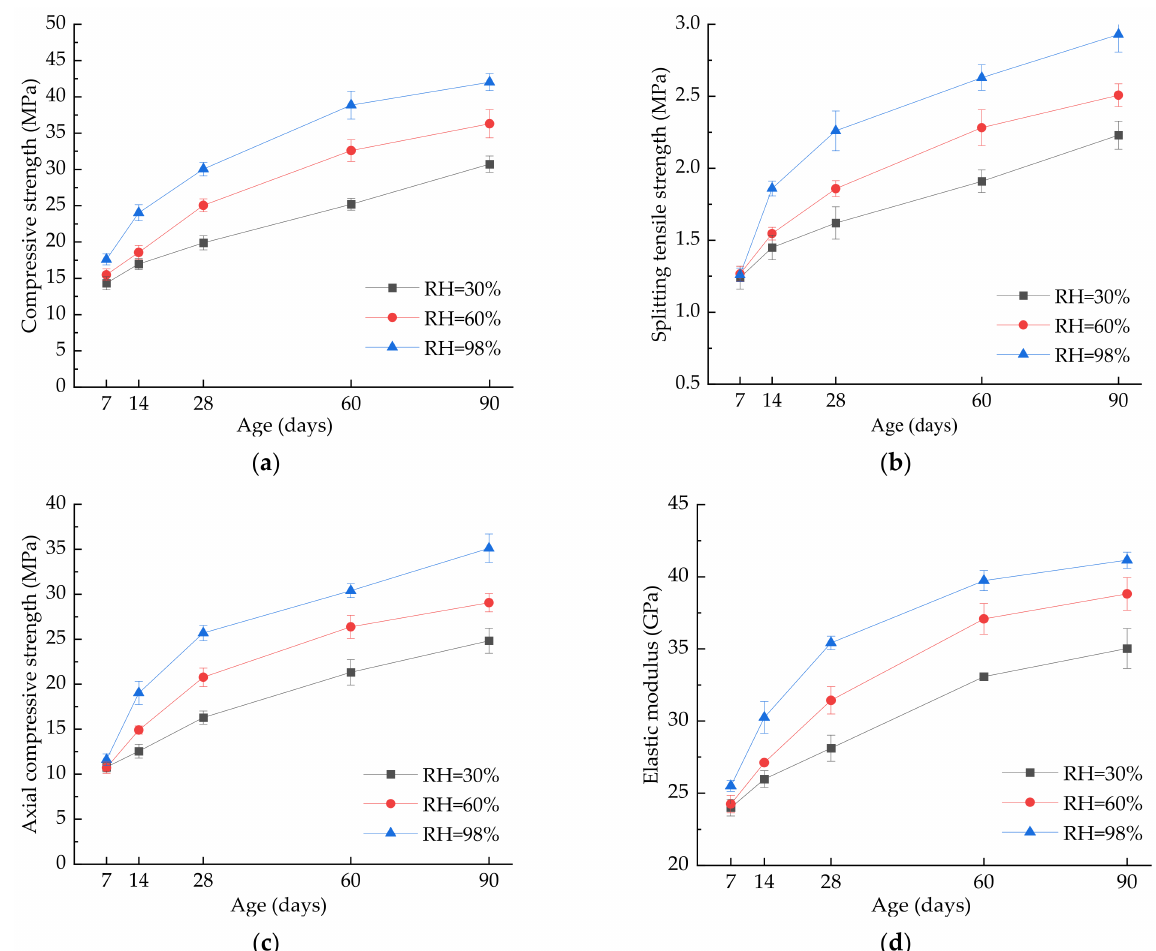
Figure 8. The variation of strength parameters of low-heat cement gallery concrete with age when the curing temperature is 20 ◦ C and curing humidity is 30%, 60% and 98%: ( a ) compressive strength; ( b ) splitting tensile strength; ( c ) axial compressive strength and ( d ) static compressive elastic